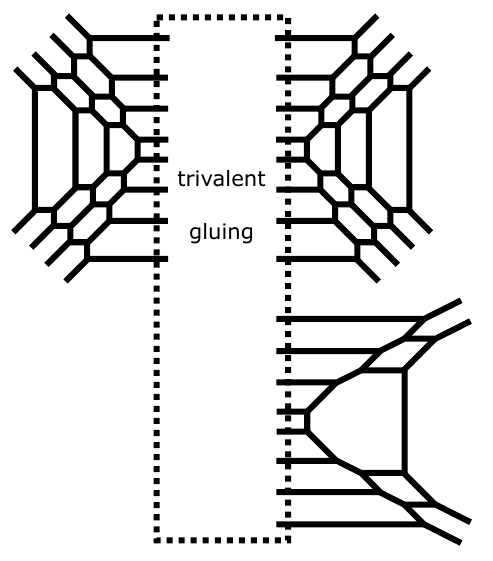
Figure 18. The web diagram for the theory (2.64) or (2.65), which is ( E 7 , E 7 ) 2 on S 1